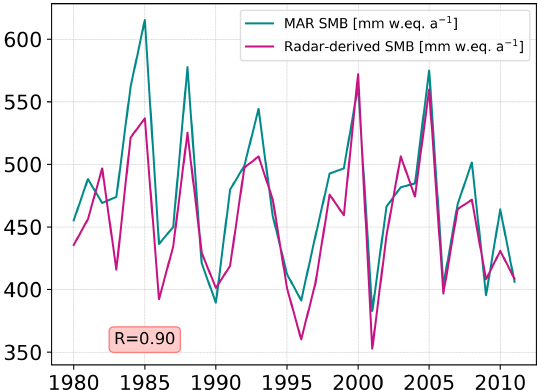
Figure 4. Time series of the annual mean (January to Decem- ber) simulated and radar-derived SMB from 1980 to 2011 over the Thwaites